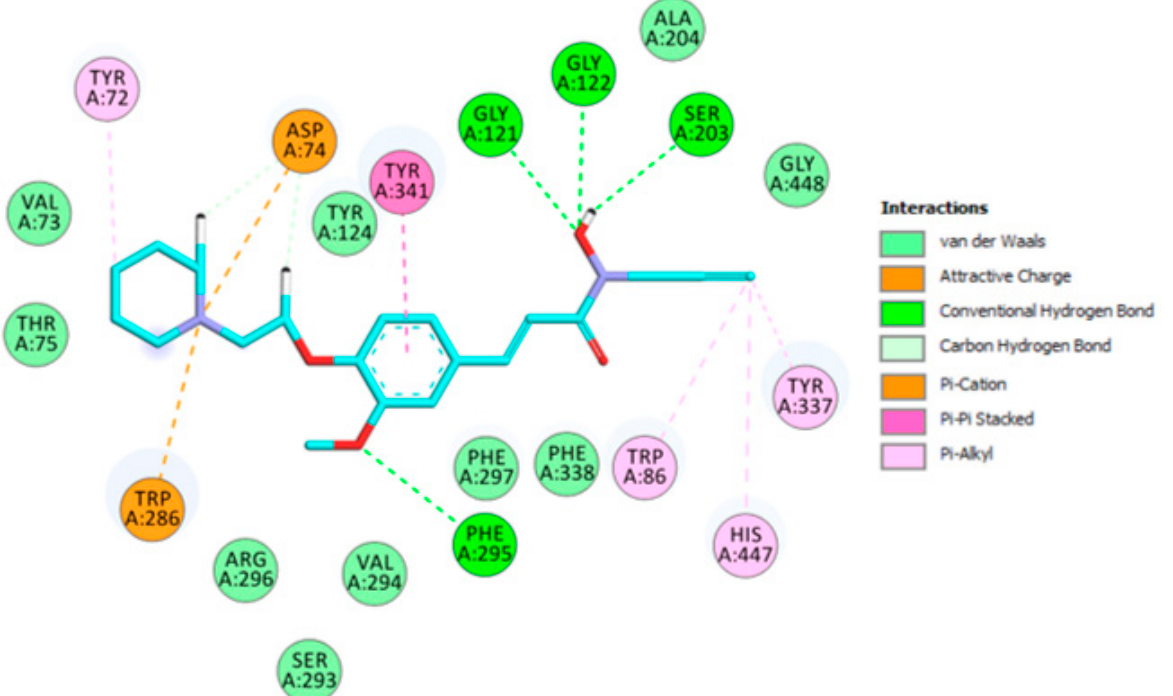
Figure 3. 2D schematic view of the interactions between compound 4 and hAChE.